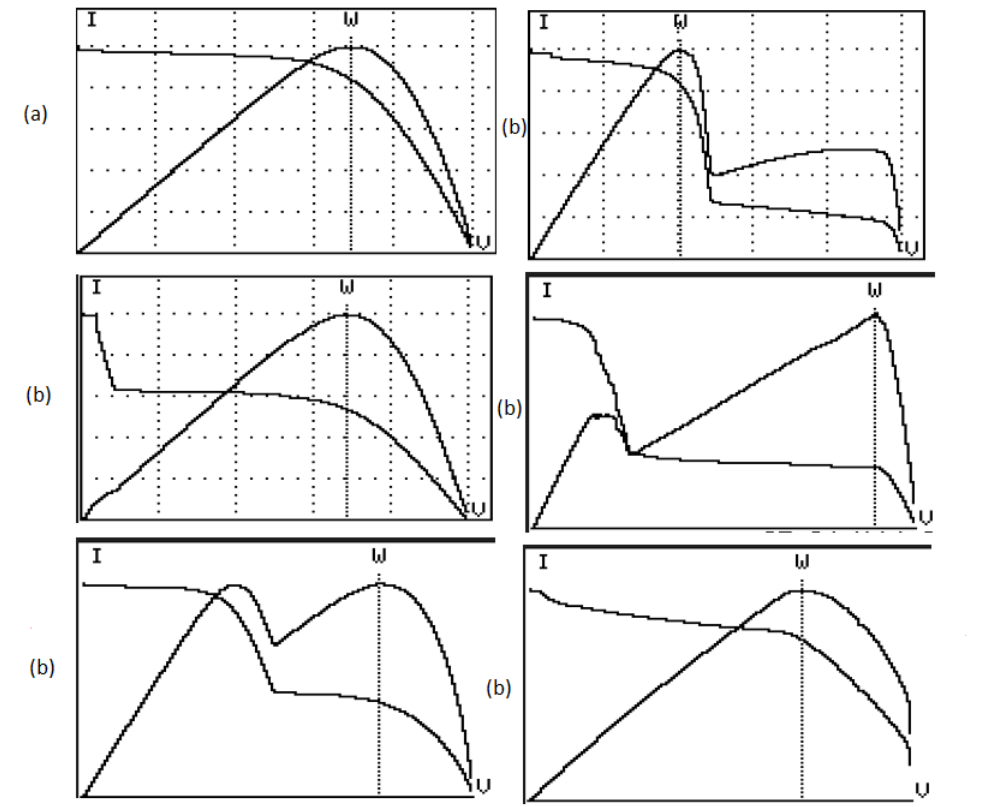
Figure 3. Screenshot of the collected I–V curves using the PROVA 210 I–V tracer, under various working conditions; ( a ) normal and ( b ) faulty I–V